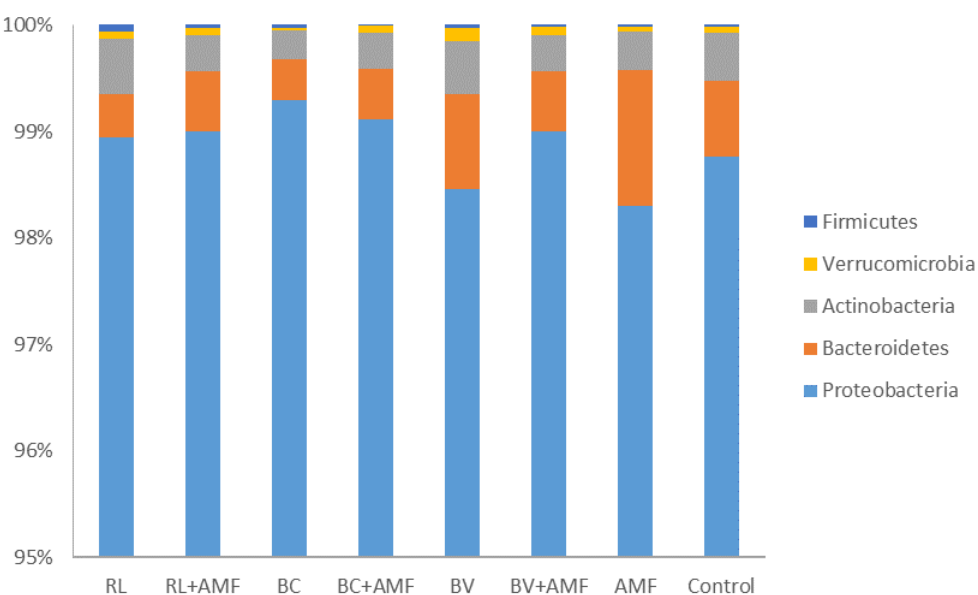
Figure 2. Relative abundance (%) of the predominant phyla in fava bean nodules of the different inoculation treatments. Others phyla and bacteria were not shown. Treatment: RL ( Rhizobium leguminosarum ), BC ( Burkholderia cenocepacia ), BV ( Burkholderia vietnamiensis ) and AMF (arbuscular mycorrhizal fungi).